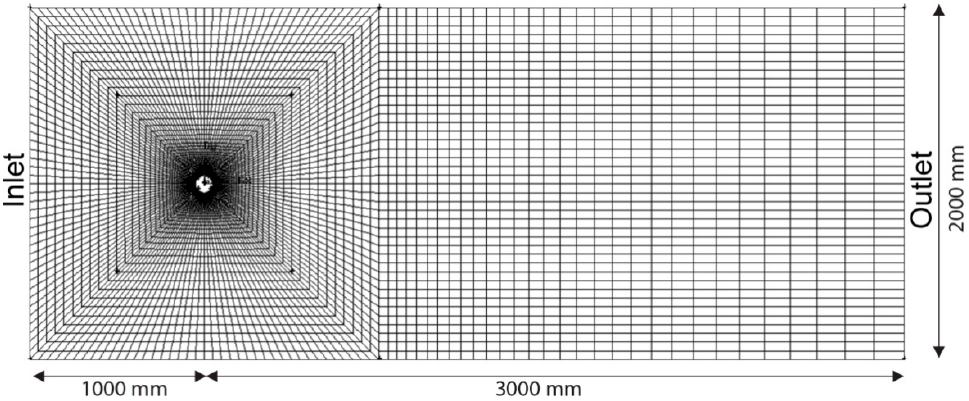
Figure 8. The cell distribution in the simulation of a flow passes through a cylinder.